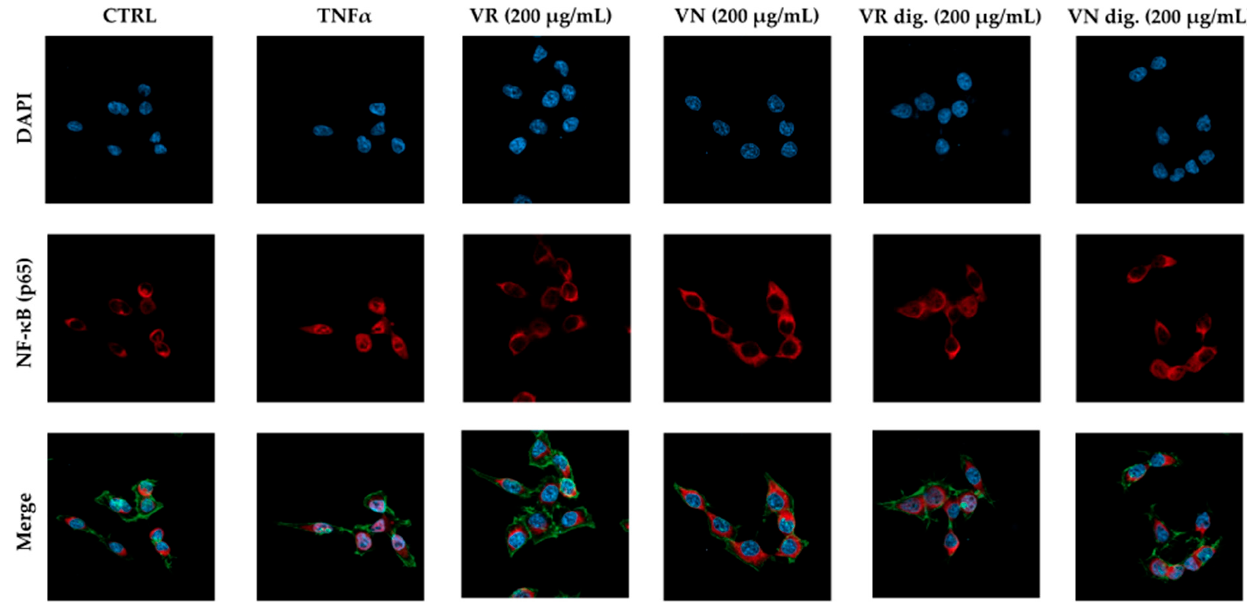
Figure 3. Effect of Castanea sativa Mill. leaf extracts on NF- κ B (p65) nuclear translocation induced by TNF α . GES-1 cells were treated for 1 h with TNF α (10 ng/mL) in addition to leaf extracts (200 µg/mL) before and after in vitro simulated digestion. NF- κ B (red) nuclear translocation from the cell cytoplasm into the nuclei (DAPI, blue) was detected by confocal immunofluorescence microscopy (63× objective). Merged images include β -actin staining (green). VR, Castanea sativa Mill. var. verdesa leaf extract; VN, Castanea sativa Mill. var. venegon leaf extract; dig., in vitro simulated digestion.